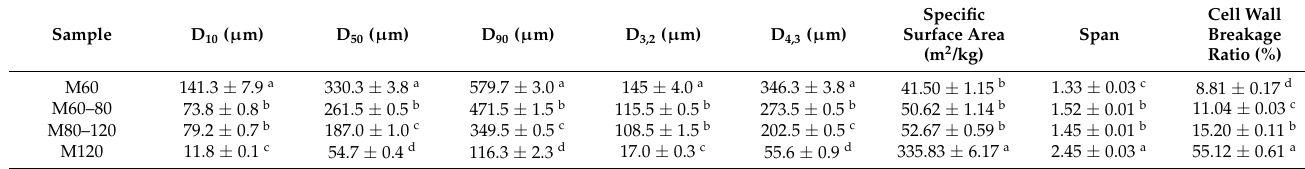
Table 1. The particle size distribution of the foxtail millet bran